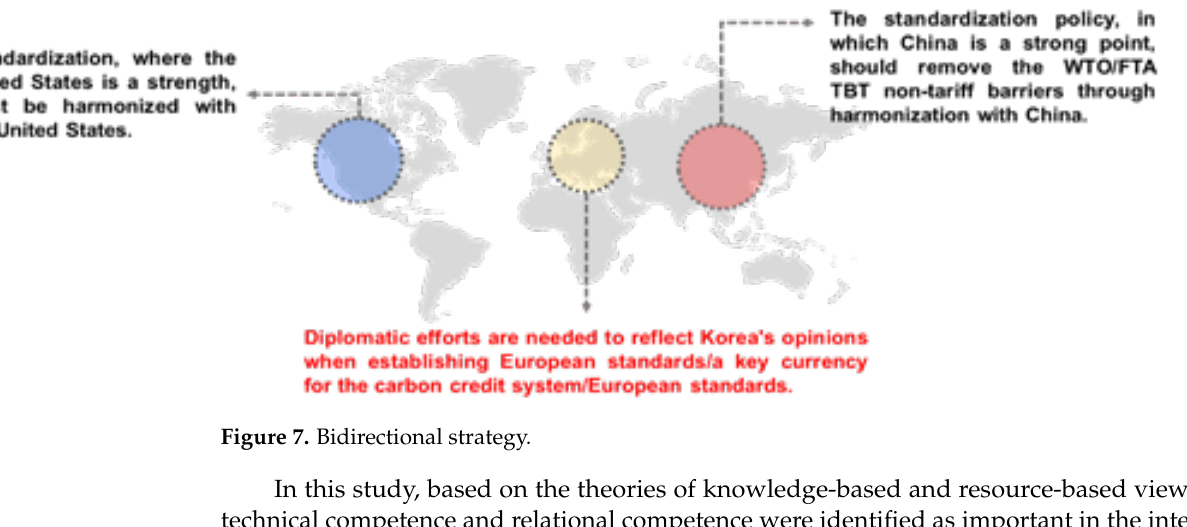
Figure 7. Bidirectional strategy .